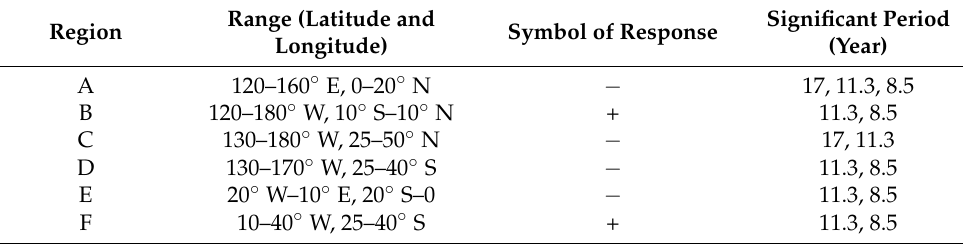
Figure 7. The composite mean difference (CMD) of 0–200 m accumulated annual STA response to SRF after 5 ‐ year running mean. The A – F regions had significant responses; a warm color indicates a positive response and a cold color indicates a negative response. All regions passed the 0.05 significance test of red noise (as verified by the difference value between peak and valley years of SRF). (Units: latitude is °N , and longitude is °E). Table 3. Extents and significant period of 0–200 m accumulated annual STA response to SRF. Region